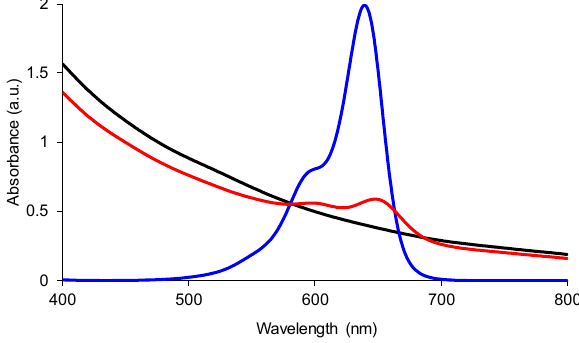
Figure 3. UV–visible spectra of aqueous suspensions containing Au@DTDTPA (black curve) and Au@DTDTPA ‐ Cy5 (red curve) and of aqueous solution of Cy5 ‐ NH 2 (blue curve).